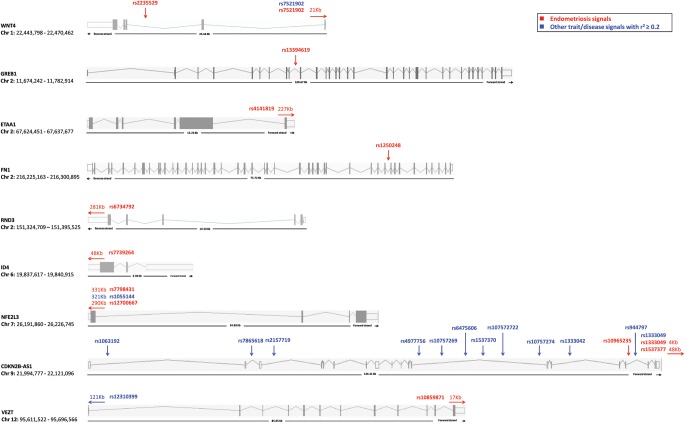
Diagrams showing the 9 genes closest to each of the 11 endometriosis SNPs included in the meta-analysis. Exons (coding regions) are presented with grey coloured boxes; lines between the exons present introns (non-coding genic regions); empty white boxes at the ends of the genes represent the 3′ and 5′ UTR regions. Each endometriosis SNP is illustrated in red, along with its distance to the gene where relevant (red arrows). SNPs genome wide associated with other trait/disease associations, that are in linkage disequilibrium (r2 > 0.2) with any of the endometriosis SNPs are illustrated in blue. See Supplementary data, Table SI for a complete list of all published SNP associations for these genomic regions including independent signals.